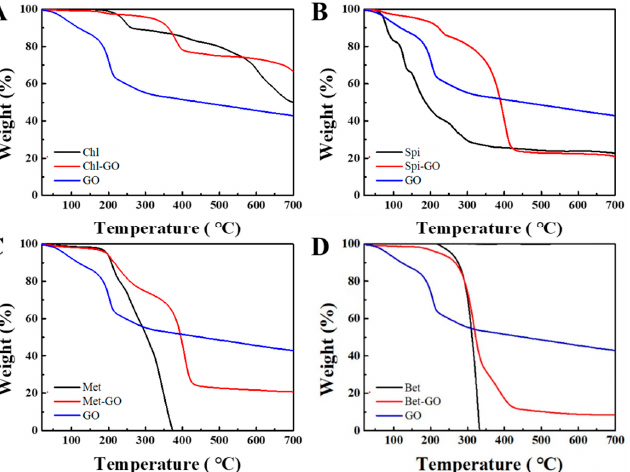
Figure 4. TGA curves of GO and pesticide-GO nanocomposites, Chl-GO (5:5) ( A ), Spi-GO (3:7) ( B ), Met-GO (3:7) ( C ) and Bet-GO (1:9) ( D